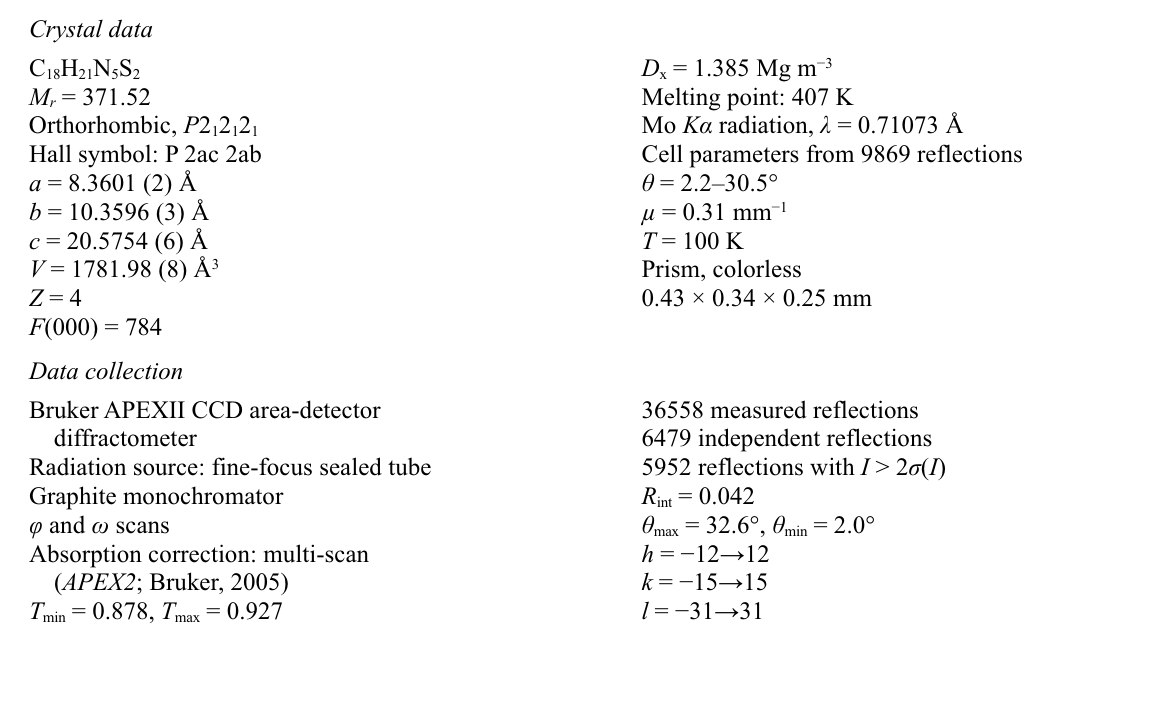
The molecular structure of the title compound with 30% probability displacement (arbitrary spheres for H atoms). 3-Ethylsulfanyl-5-methyl-1-phenyl-7-pyrrolidin-1-yl-1 H - pyrimido[4,5- e